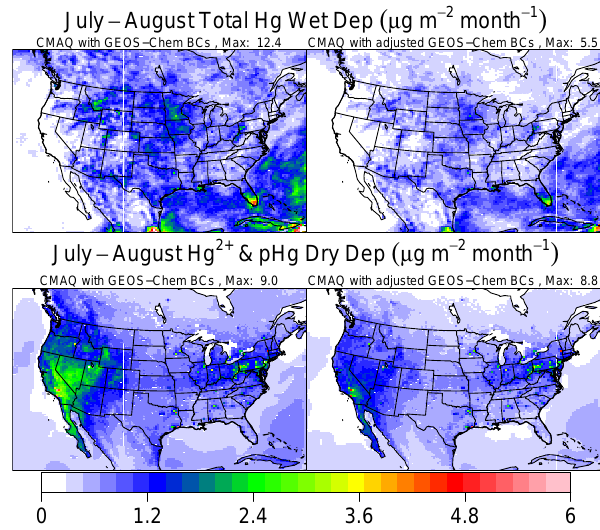
Fig. 5b. Comparison of simulated dry and wet deposition for July– August 2002 from CMAQ runs using original GEOS-Chem based boundary conditions and adjusted boundary conditions. Circles on wet deposition plots indicate locations of Mercury Deposition Net- work wet deposition observations. Dry deposition includes only di- valent forms of